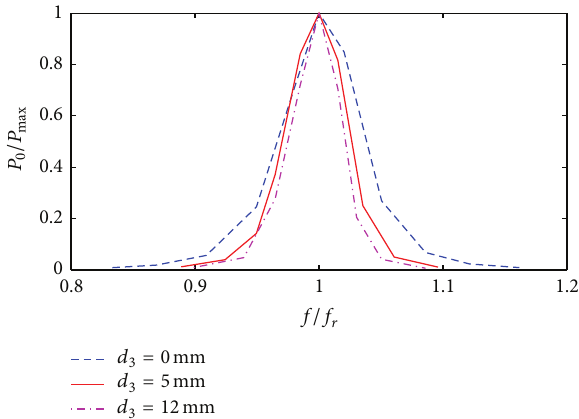
Figure 6: Variation of load power with frequency at various 𝑑 3 values.